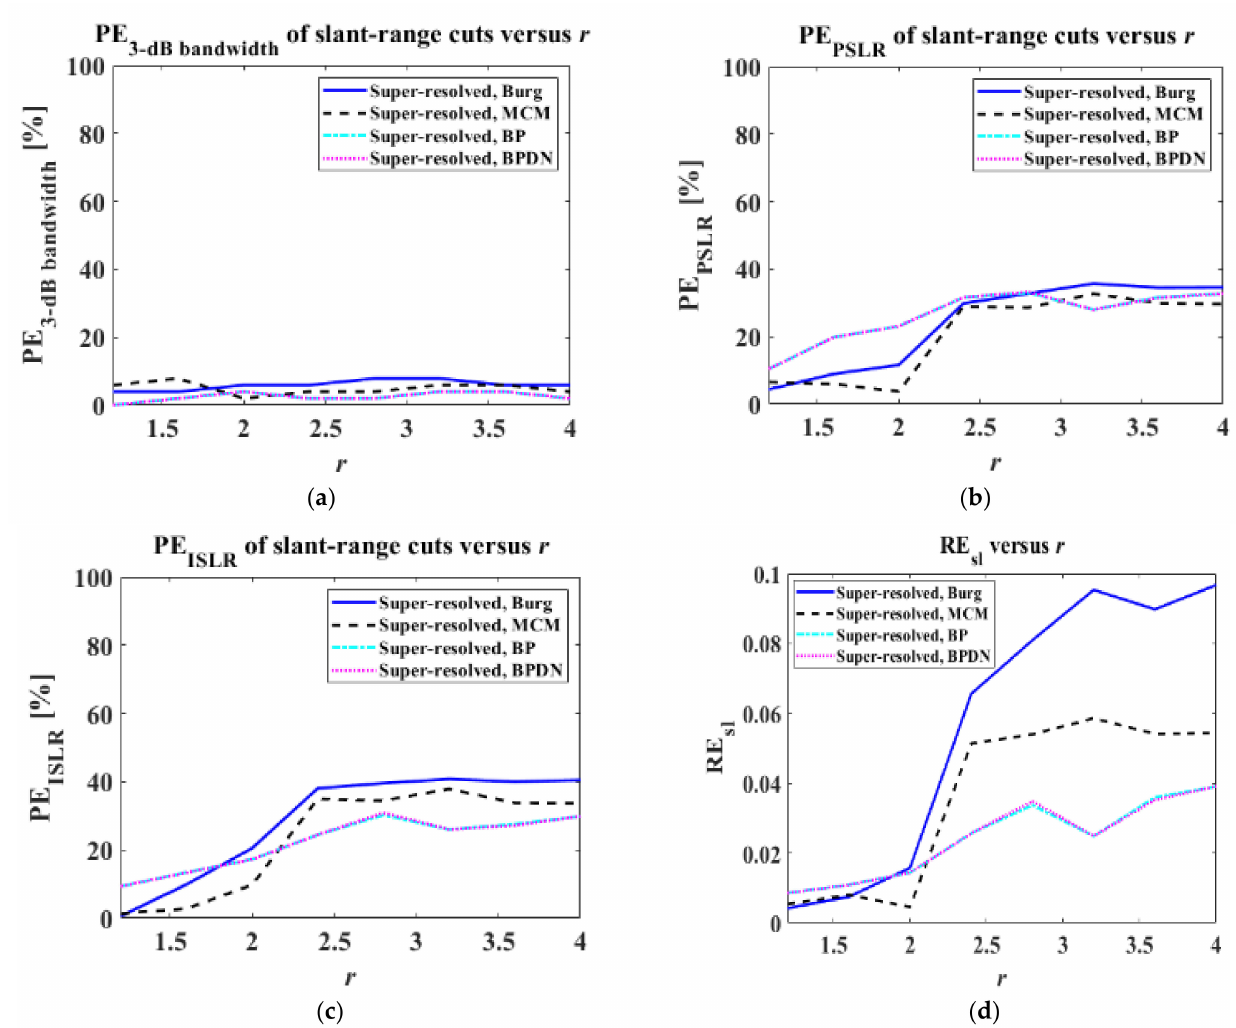
Figure 7. PE 3 − dB bandwidth , PE PSLR , PE ISLR , and RE sl versus r : ( a ) PE 3 − dB bandwidth , ( b ) PE PSLR , ( c ) PE ISLR , ( d ) RE sl